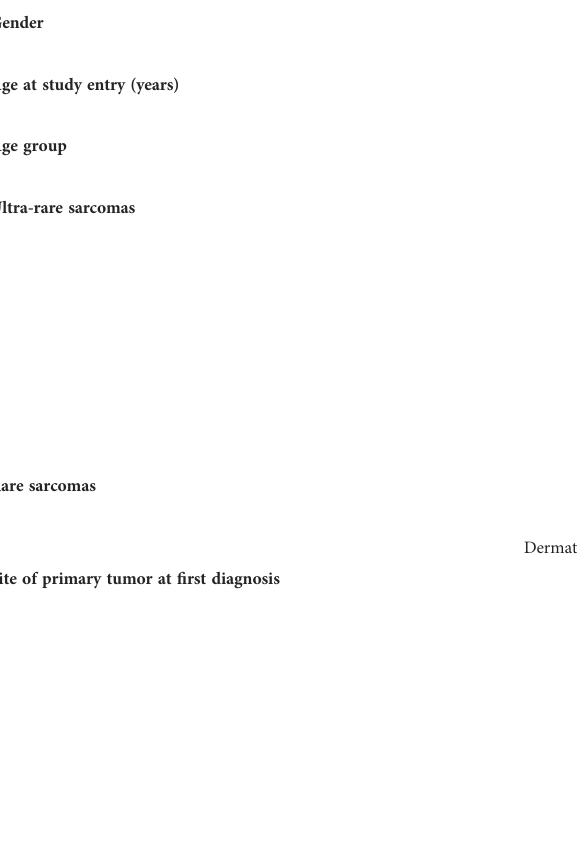
TABLE 1 Patient and disease characteristics at